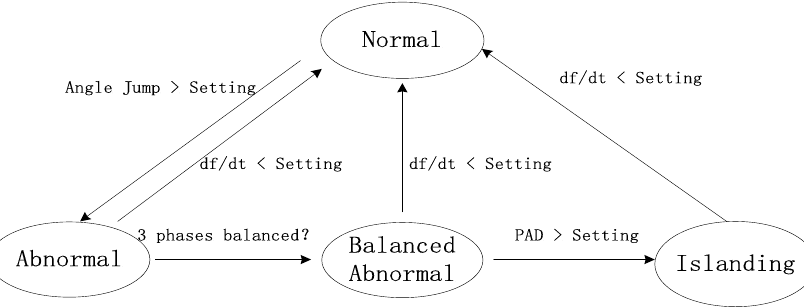
Figure 4. State machine of composite phase angle drift (PAD) method.